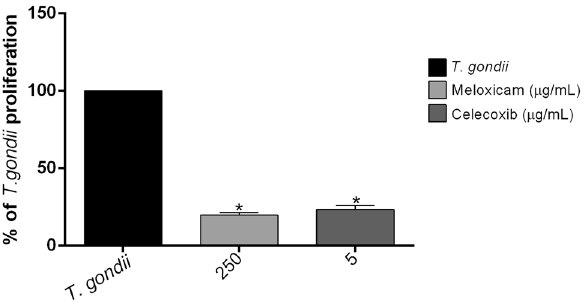
Figure 8. T. gondii intracellular proliferation in human villous explants treated with COX-2 inhibitors. Villous explants were infected with T. gondii for 24 h, and treated with meloxicam or celecoxib for an additional 24 h. Next, the villous explants were macerated for β-galactosidase assay, and data were presented as percentage (%) of T. gondii proliferation in relation to untreated and infected villous (100% of intracellular proliferation). Data were shown as mean ± SEM from two independents experiments with eight replicates. Differences between groups were analyzed by Kruskal–Wallis test and Dunn’s multiple comparison post-test (GraphPad Prism Sofware version 6.01, https:// www. graph pad. com). Significant differences in relation to untreated and infected villous ( * T. gondii ). Differences were considered significant when P <